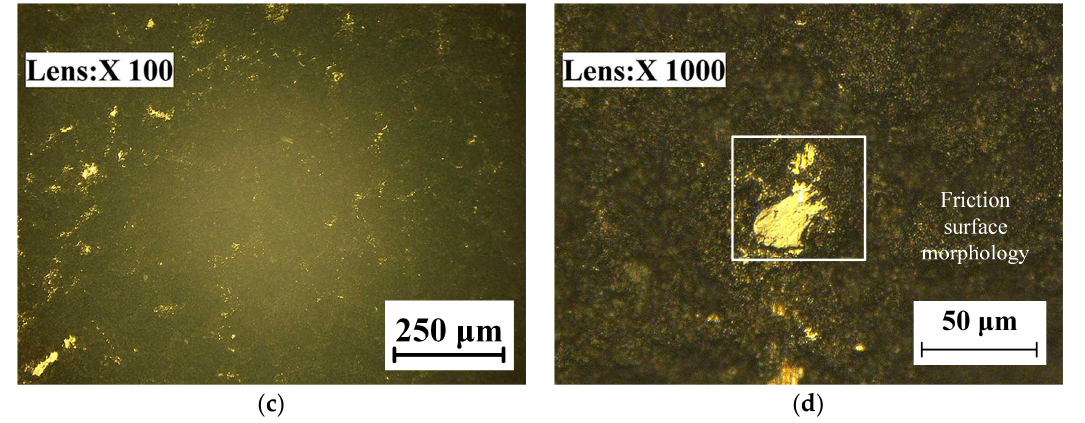
Figure 17. The wear morphology of TC18 substrate and WC-12Co coating. ( a ) The substrate wear morphology at 100 times magnification; ( b ) The substrate wear morphology at 300 times magnification; ( c ) The coating wear morphology at 100 times magnification; ( d ) The coating wear morphology at 1000 times magnification.